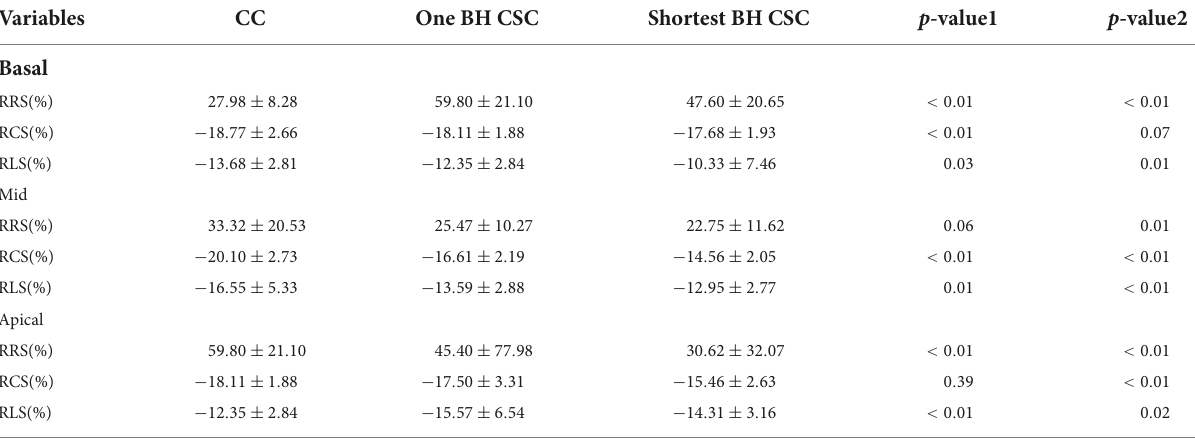
TABLE 4 3D left ventricular regional strain assessment between cines.